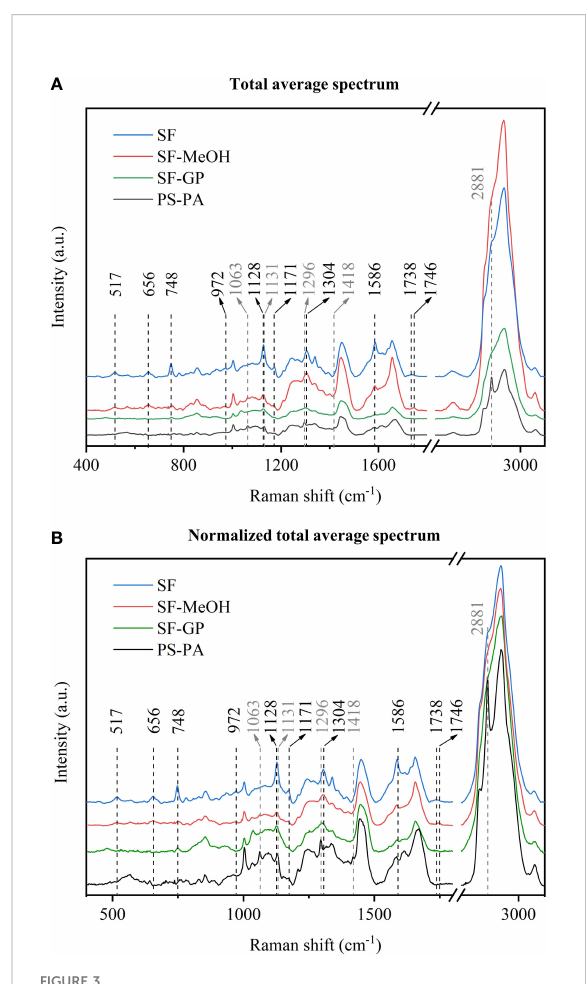
FIGURE 3 Comparative analysis of the spectra by the four different methods. (A) Average spectra. (B) Normalized average